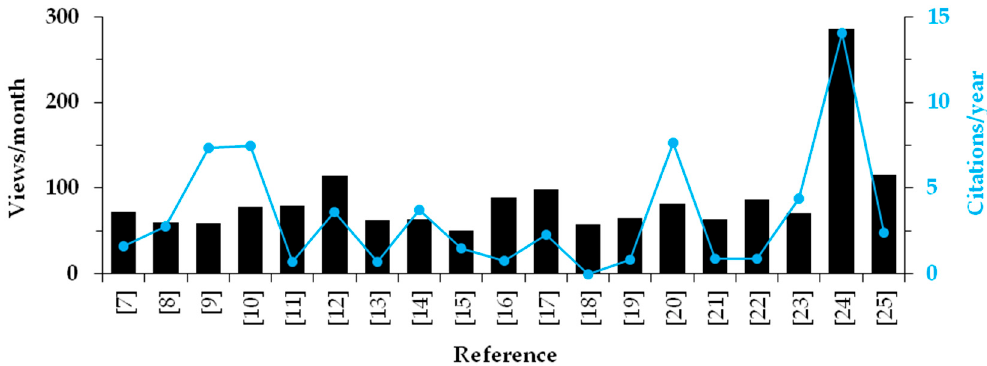
Figure 2. Views and citations attracted by the 19 research papers composing the Special Issue “Remote Sensing of Volcanic Processes and Risk” [5] of Remote Sensing .